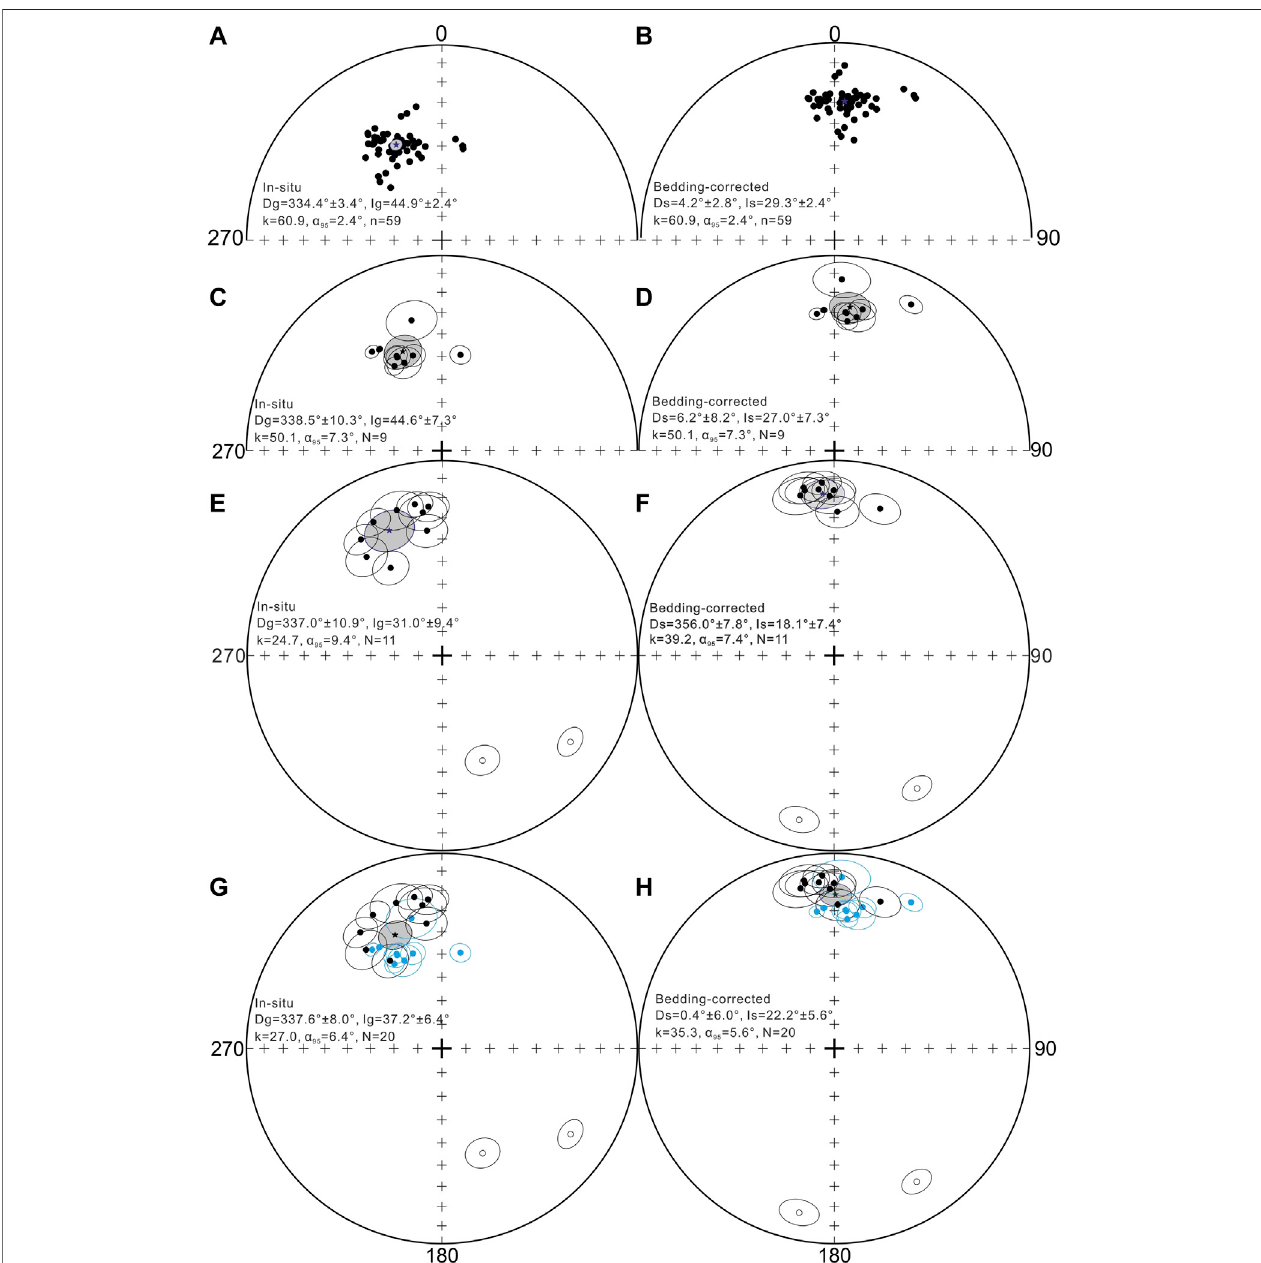
FIGURE8| Equal-areaprojectionsofisolatedsite-meanChRM directionswithcorresponding 95%con fi denceellipsesbeforeand aftertiltcorrection(leftandright columns). (A,B) Equal-area projections of fi ltered ChRMs from isolated 59 specimens of the Lower Cretaceous Zonggei Formation volcanic rocks with Fisher mean and corresponding 95% con fi dence ellipses before and after tilt correction (left and right columns); (C,D) equal-area projections of site-mean ChRM directions isolated from 9 group-meansof theZonggei Formation volcanicrocks withFisher mean and corresponding95% con fi dence ellipses before and after tilt correction (left and right columns); (E,F) equal-area projections of 11 site-mean directions with Fisher mean and corresponding 95% con fi dence ellipses of the Duoni Fm. volcano-sedimentary rocks before and after tilt correction (left and right columns); (G,H) equal-area projections of combined 9 group-mean directions of the Lower Cretaceous Zonggei Formationvolcanicrocksand fi ltered11site-meandirectionsfromresultsoftheDuoniFormationvolcano-sediments,whicharederivedfromLiZ.etal.(2017)withFisher meansand corresponding95%con fi dence ellipses beforeand after tiltcorrection(left and right columns).Solid and open symbols representprojectionsonto lowerand upper hemisphere, respectively. Stars with light gray-colored ellipses indicate the overall mean directions and the 95% con fi dence limits before and after tilt correction, respectively. Blue solid circles represent the 9 group-mean directions from the Lower Cretaceous Zonggei Formation volcanic rocks in this study.